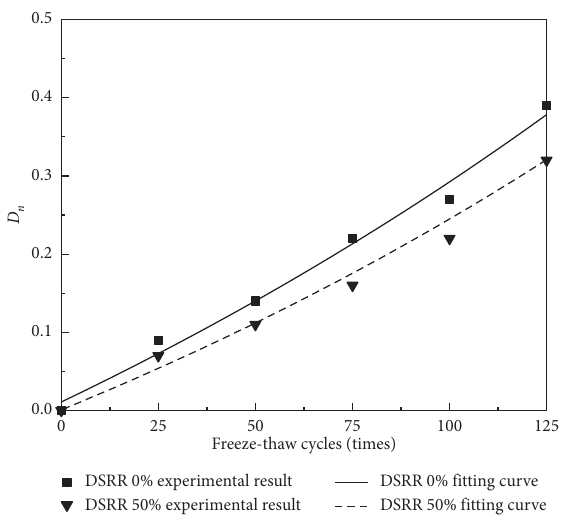
Figure 9: Relation between D